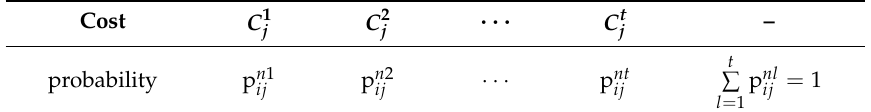
Table 3. Posterior Probability of Microgrid j for Selecting Type n Cost Function of Microgrid i